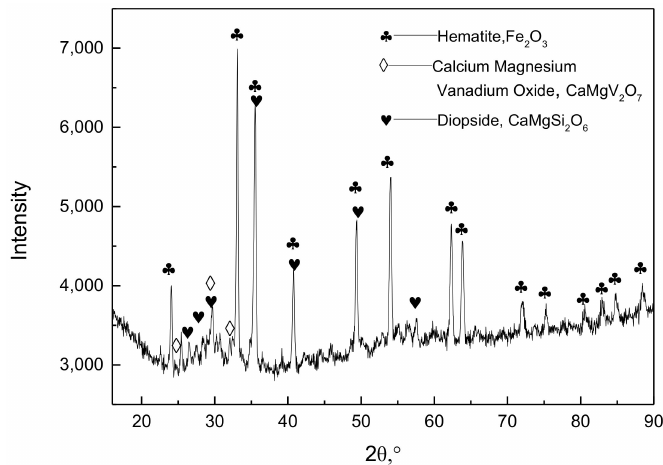
Figure 3. X-ray diffraction pattern for vanadium slag roasted at 850 ◦ C for 150